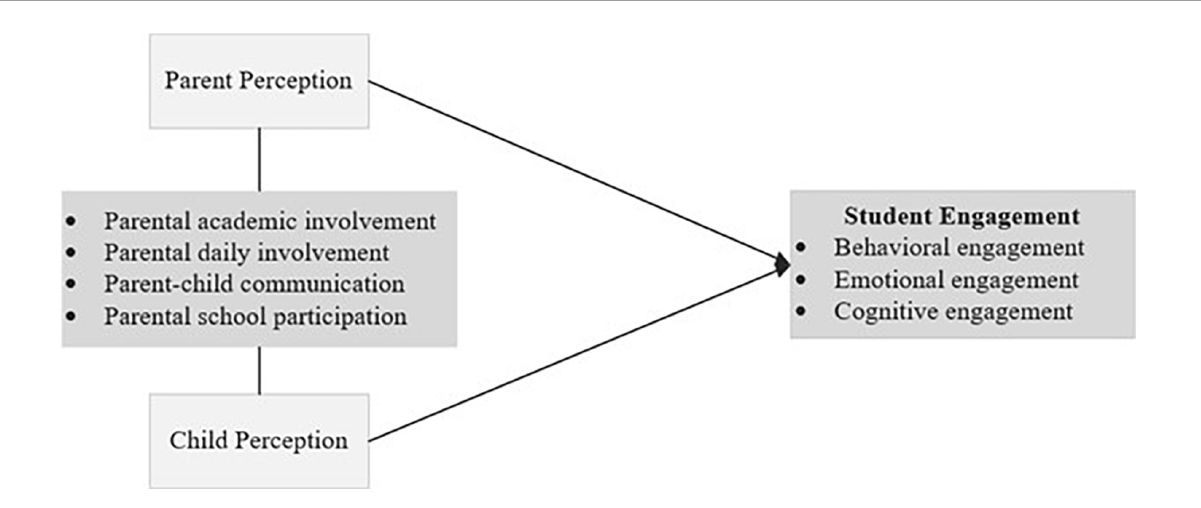
FIGURE1 Study framework guiding the present